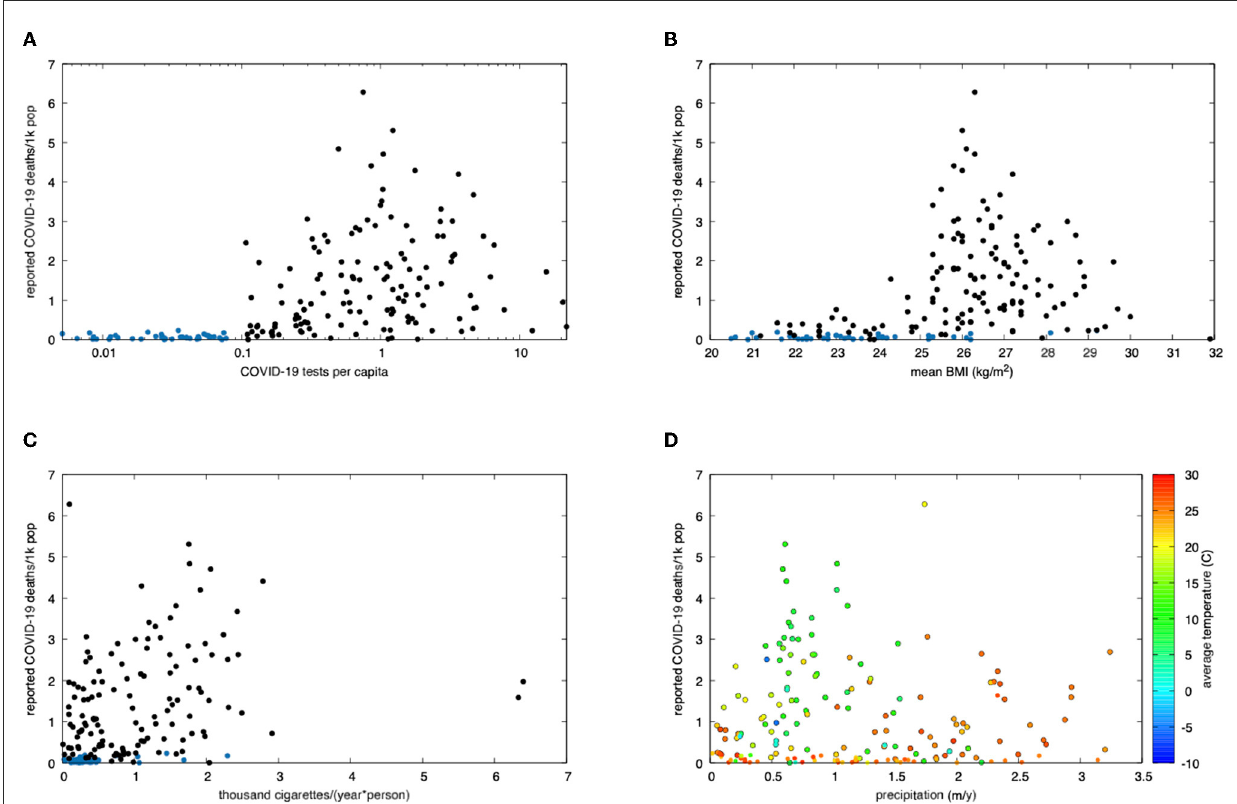
FIGURE1 Correlation plots analysing COVID-19 mortality as a function of BMI, cigarette consumption, annual precipitations and average temperature in 181 countries worldwide COVID-19 data covers about 2 years, from initial counting until 25 March 2022. Purportedly under-reporting countries are shown in blue in the first three panels and edgeless in the last one. (A) Scattered plot of reported COVID-19 deaths vs. tests per capita (worldometers.info, retrieved on 25 March 2022). Under-reporting of deaths seems more likely below about 50 tests per thousand people per year. (B) Scattered plot of reported deaths per thousand due to COVID-19 (worldometers.info) vs. mean BMI (31). (C) Scattered plot of reported deaths per thousand due to COVID-19 vs. cigarette smoking (tobaccoatlas.org, 2016). (D) Average annual precipitation (35) and temperature (1961–1990 data, Climatic Research Unit, 2011). Warmer and humid areas experienced reduced mortality. Data source: Mitchell, T.D., Carter, T.R., Jones, P.D., Hulme, M., New, M., 2003: A Comprehensive Set of High-Resolution Grids of Monthly Climate for Europe and the Globe: the Observed Record (1901–2000) and 16 Scenarios (2001–2100). J. Climate: